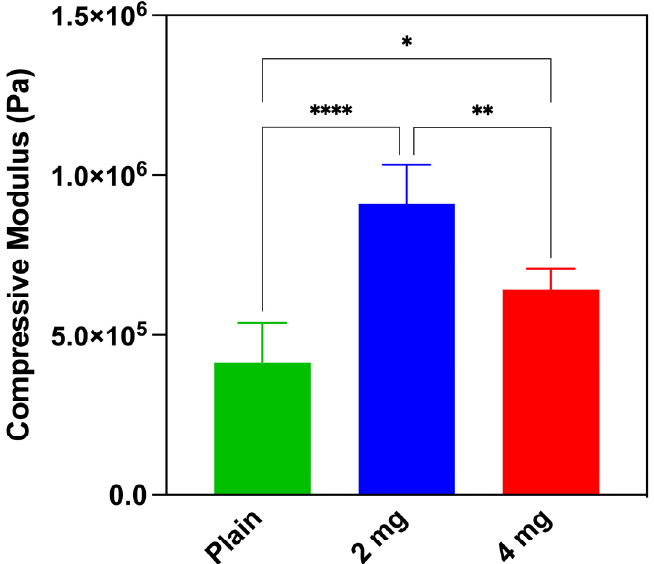
Figure 4. Mechanical characterization of the scaffolds: (green) PLGA scaffolds, (blue) 2 mg nHA/PLGA scaffolds, and (red) 4 mg nHA/PLGA scaffolds. The compressive modulus is expressed as the mean ± SD. The data are representative of n = 5 scaffolds per type. * p < 0.05, ** p < 0.01, **** p < 0.0001.